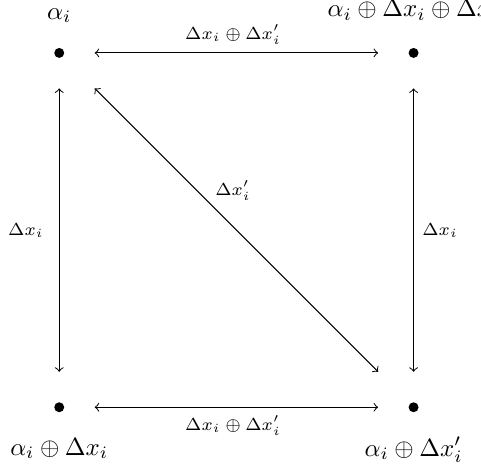
Figure 1: A schematic of the related differences and the associated quartet. The square collapses to a line or point depending on ∆ x i and ∆ x 0